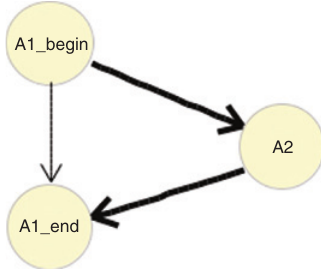
Figure 3: MSDR-SP Rule Represented by a